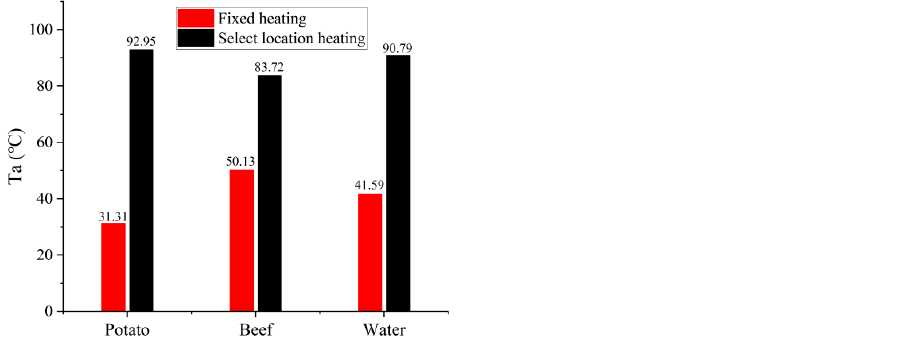
Figure 17. Comparison of body average temperature of different materials in select location heating and fixed heating.